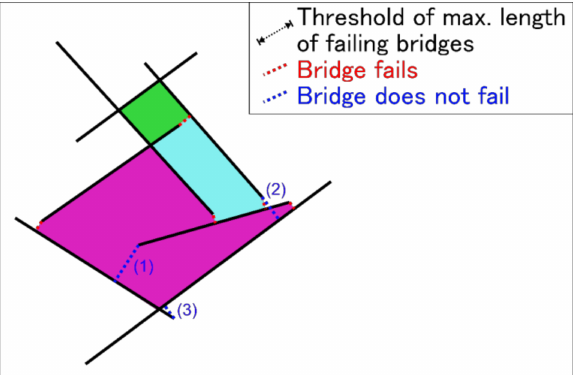
Figure 3. Schematic illustration showing the rock bridge failure procedure between pre-existing fractures (black lines) and the development of closed